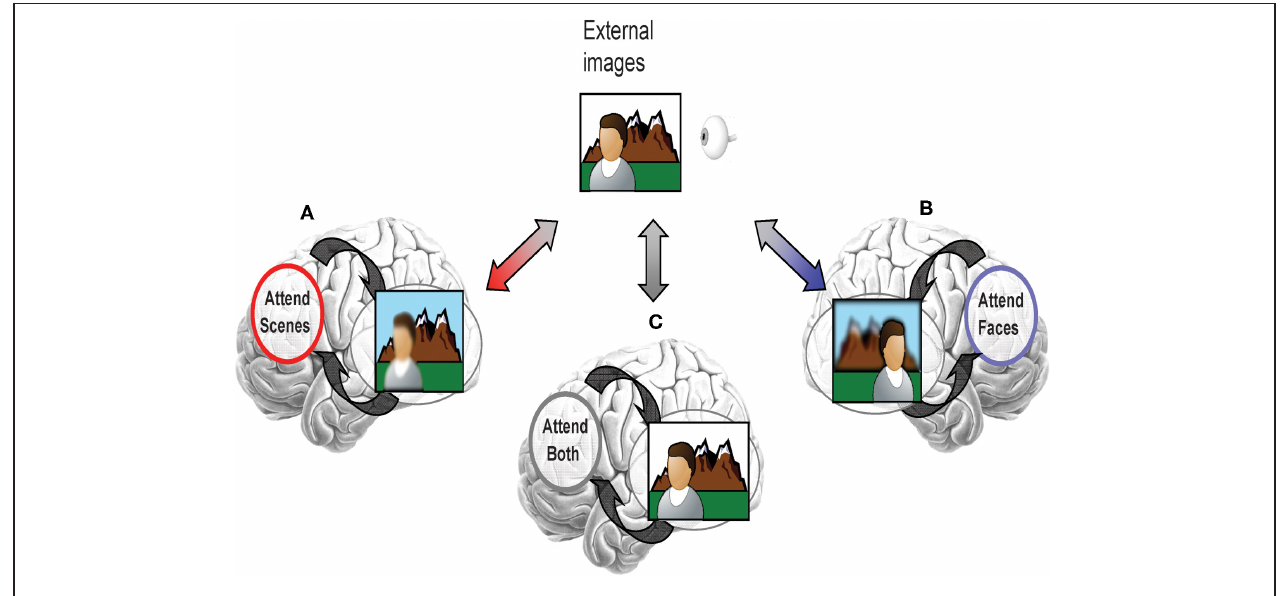
representation of scenes. However, if attention were selectively directed toward faces, then, (B) network codes would be tuned to favor representation of scenes. (C) If both faces and scenes are task-relevant, then there should be no bias toward one or another